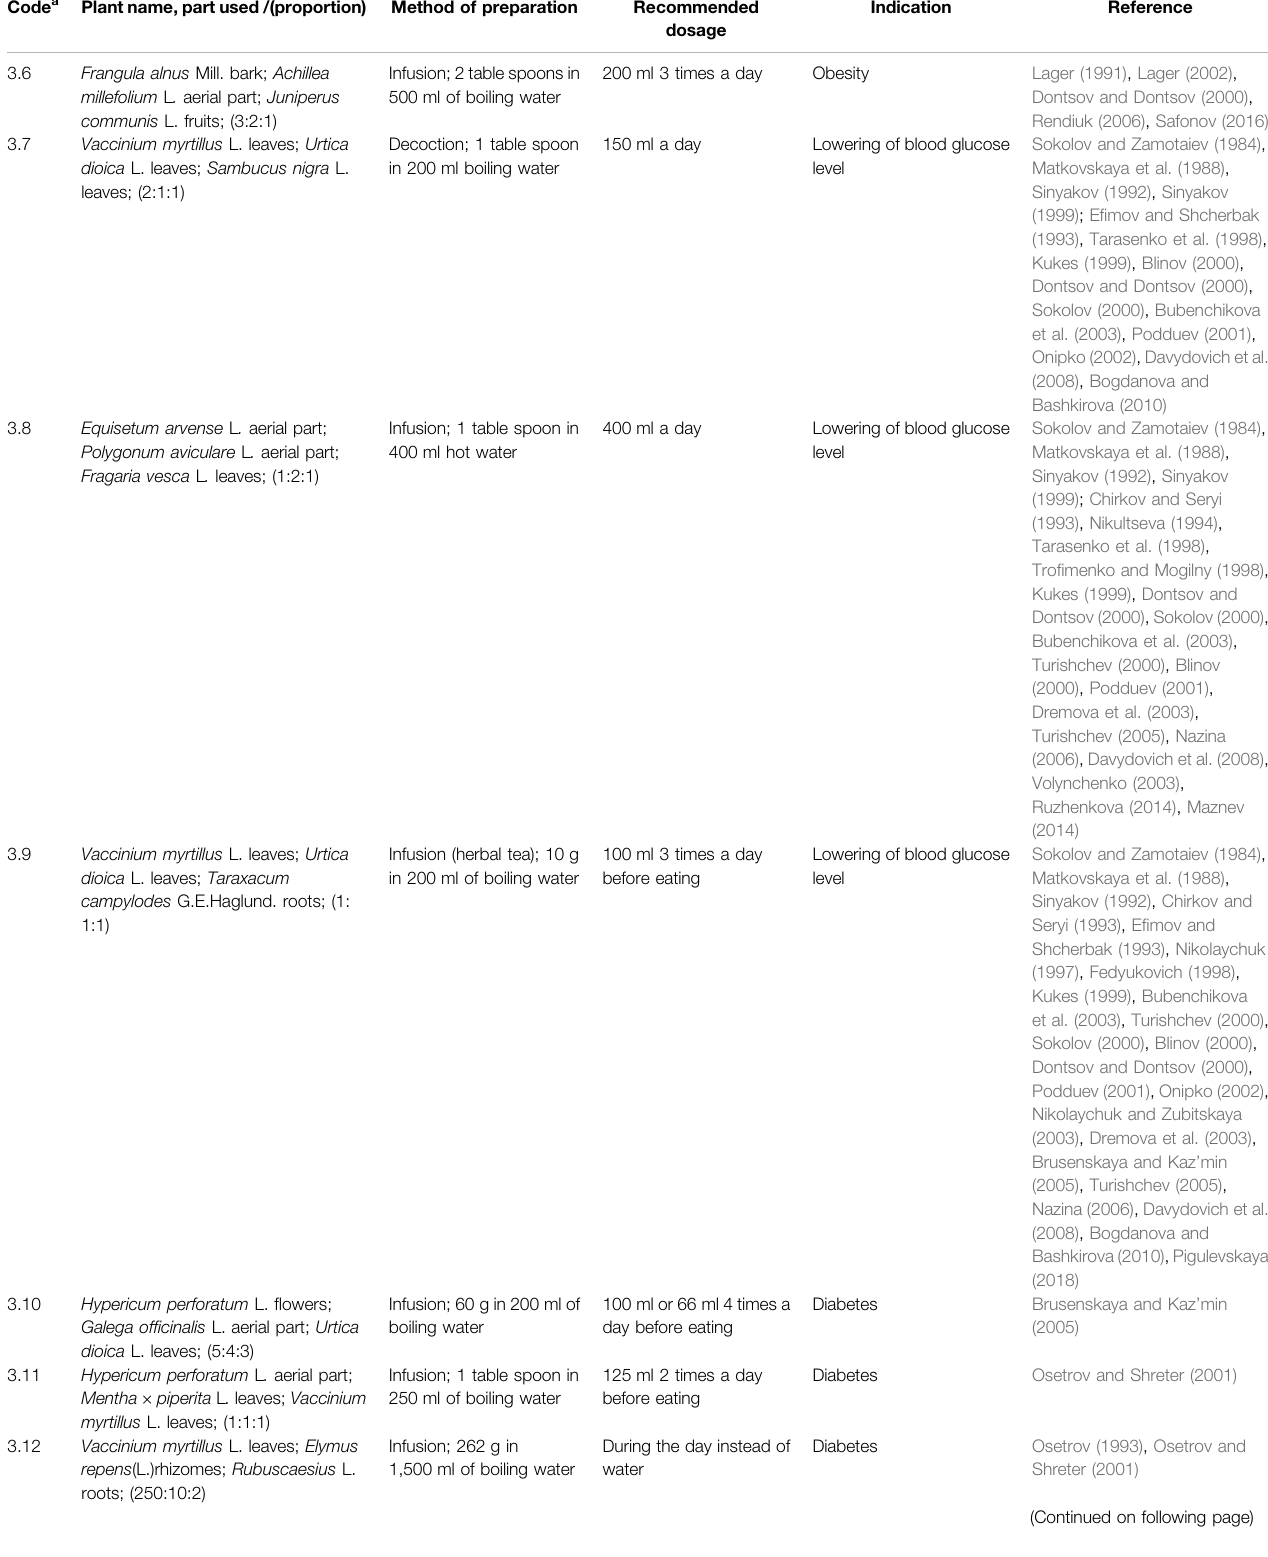
TABLE 1 | ( Continued ) The list of medical species used for the management of diabetes and related disorders in Russia. Code a Plant name, part used /(proportion) Method of